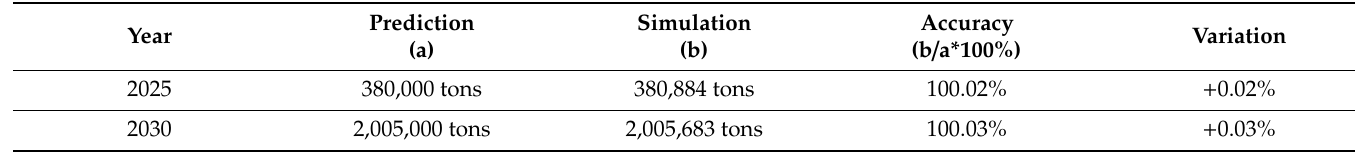
Table 19. Prediction of LNG Fuel Consumption by